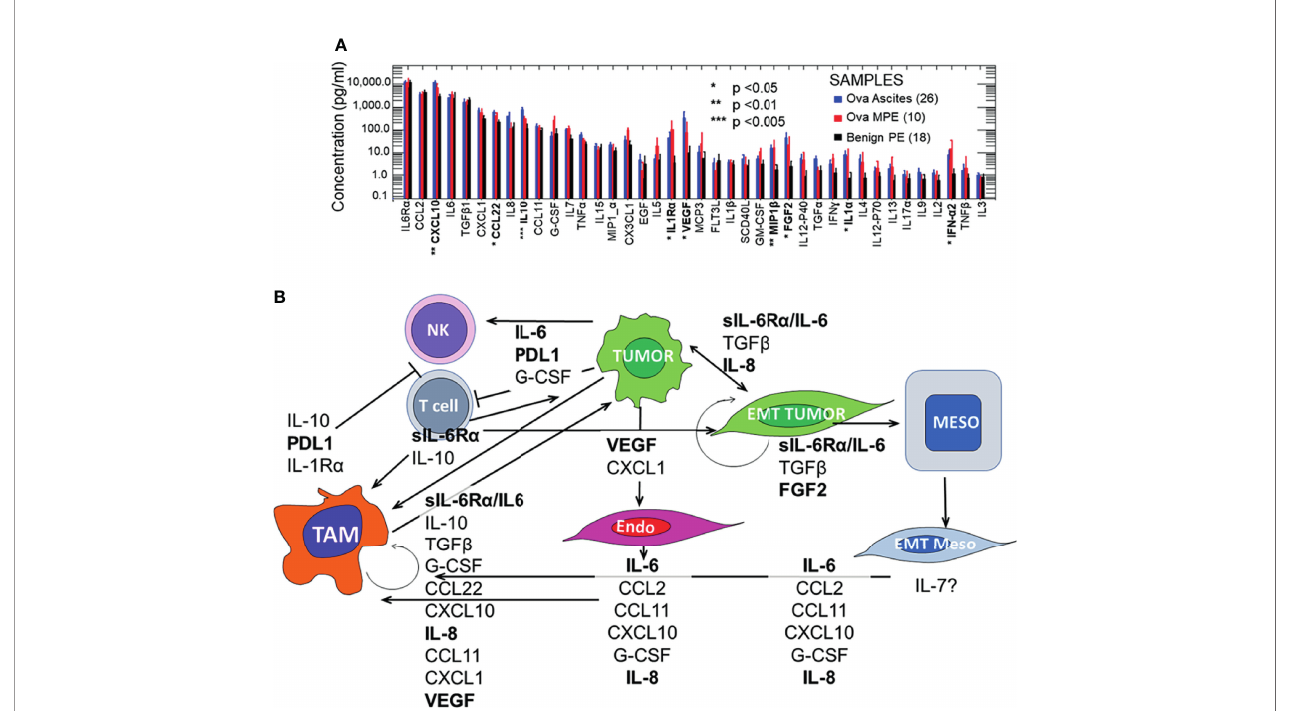
FIGURE 1 | Pleural and peritoneal secretomes in ovarian cancer and benign pleural effusions. Panel (A) Pleural and peritoneal secretomes are dominated by immunosuppressive and EMT tumor promoting cytokines and chemokines (IL-6/IL-6R a , VEGF, IL-8, CXCL10, and IL-10). Data were log-transformed for analysis. There were no signi fi cant differences between analytes in ovarian ascites and malignant pleural effusions (MPE). Data for ovarian ascites and MPE were pooled and compared to Benign PE (Student ’ s 2-tailed t test). Results were Bonferroni corrected for 40 comparisons. Statistically signi fi cant comparisons are indicated in bold typeface. Effusions and ascites were collected as anonymized medical waste under a University of Pittsburgh IRB exemptions (Nos. 0503126 and 0403111). Thirteen pleural effusions were collected from patients without pleural malignancy (11 with heart failure, 2 with asbestosis). The benign effusion data have been published previously (7, 8). Cytokines were quanti fi ed on the Luminex platform, using the Curiox LT-MX plate washer, Curiox DA-96 plates, the Luminex 200 System analyzer and xPonent data acquisition and analysis software. Cytokines were measured in 5 µL of neat, clari fi ed effusion using the MILLIPLEX MAP Human Cytokine/ Chemokine Magnetic Bead Panel - Premixed 38 Plex (Cat. No. HCYTMAG-60K-PX38), MILLIPLEX MAP Human TGF b (Cat. No. TGFBMAG-64K-01) and IL-6R a from the Human Angiogenesis/Growth Factor Panel 2 (Cat. No. HANG2MAG-12K-01) kits, as previously published (Donnenberg et al., https://doi.org/10.18632/ oncotarget.27290). Panel (B) Effects of the malignant secretome on cavitary cell types and mesothelial maintenance. The 10 most prominent cytokines and chemokines (geometric mean ≥ 100 pg/mL) in intracavitary ovarian cancer are shown, plus PDL1 which is expressed on intracavitary macrophages and must be addressed for successful intra-cavitary therapy. The variety of cell types, cytokines and chemokines involved, and the potential to amplify effects through autocrine and juxtacrine feedback loops justi fi es the need for multimodal intra-cavitary therapy. Potential therapeutic targets for which on- or off-label FDA approved agents are currently available are shown in bold